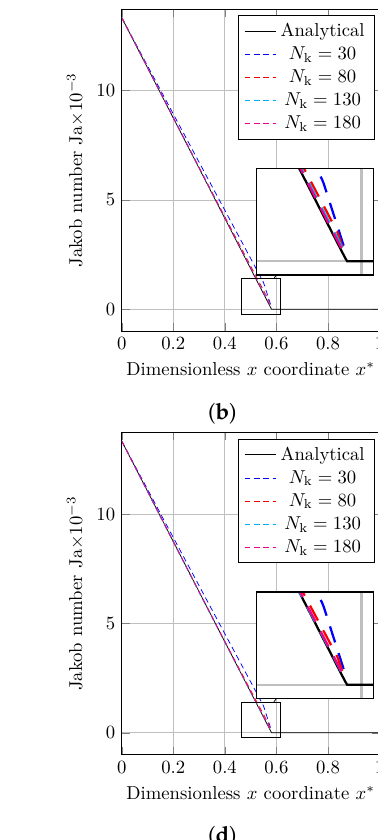
Figure 3. A comparison between the numerical data achieved using the VOF and CLSVOF techniques with the numerical solutions to the evaporation by heat conduction problem. ( a ) The thickening of the vapor film’s dimensionless thickness with respect to time as calculated using the VOF technique is shown. ( b ) The Jakob number profile throughout the dimensionless length as determined using the VOF approach is shown. ( c ) The thickening of the vapor film’s dimensionless thickness with respect to time, as determined using the CLSVOF technique. ( d ) CLSVOF technique was used to obtain Jakob number distribution throughout the dimensionless length.